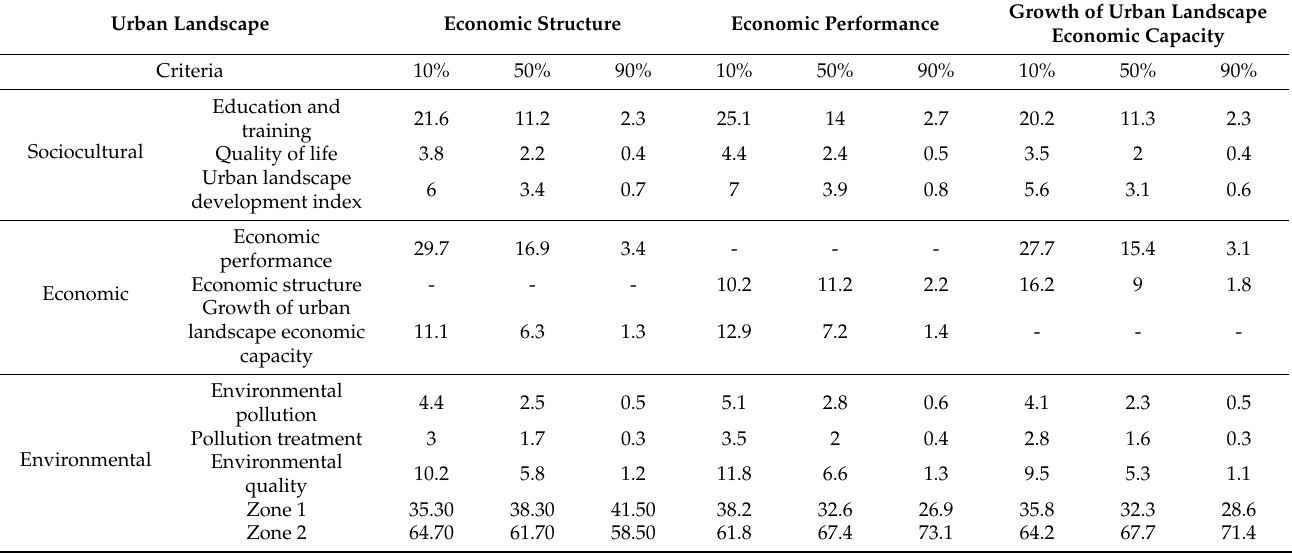
Table 9. Sensitivity analysis between economic, environmental, and sociocultural criteria and alterna- tives for Penang